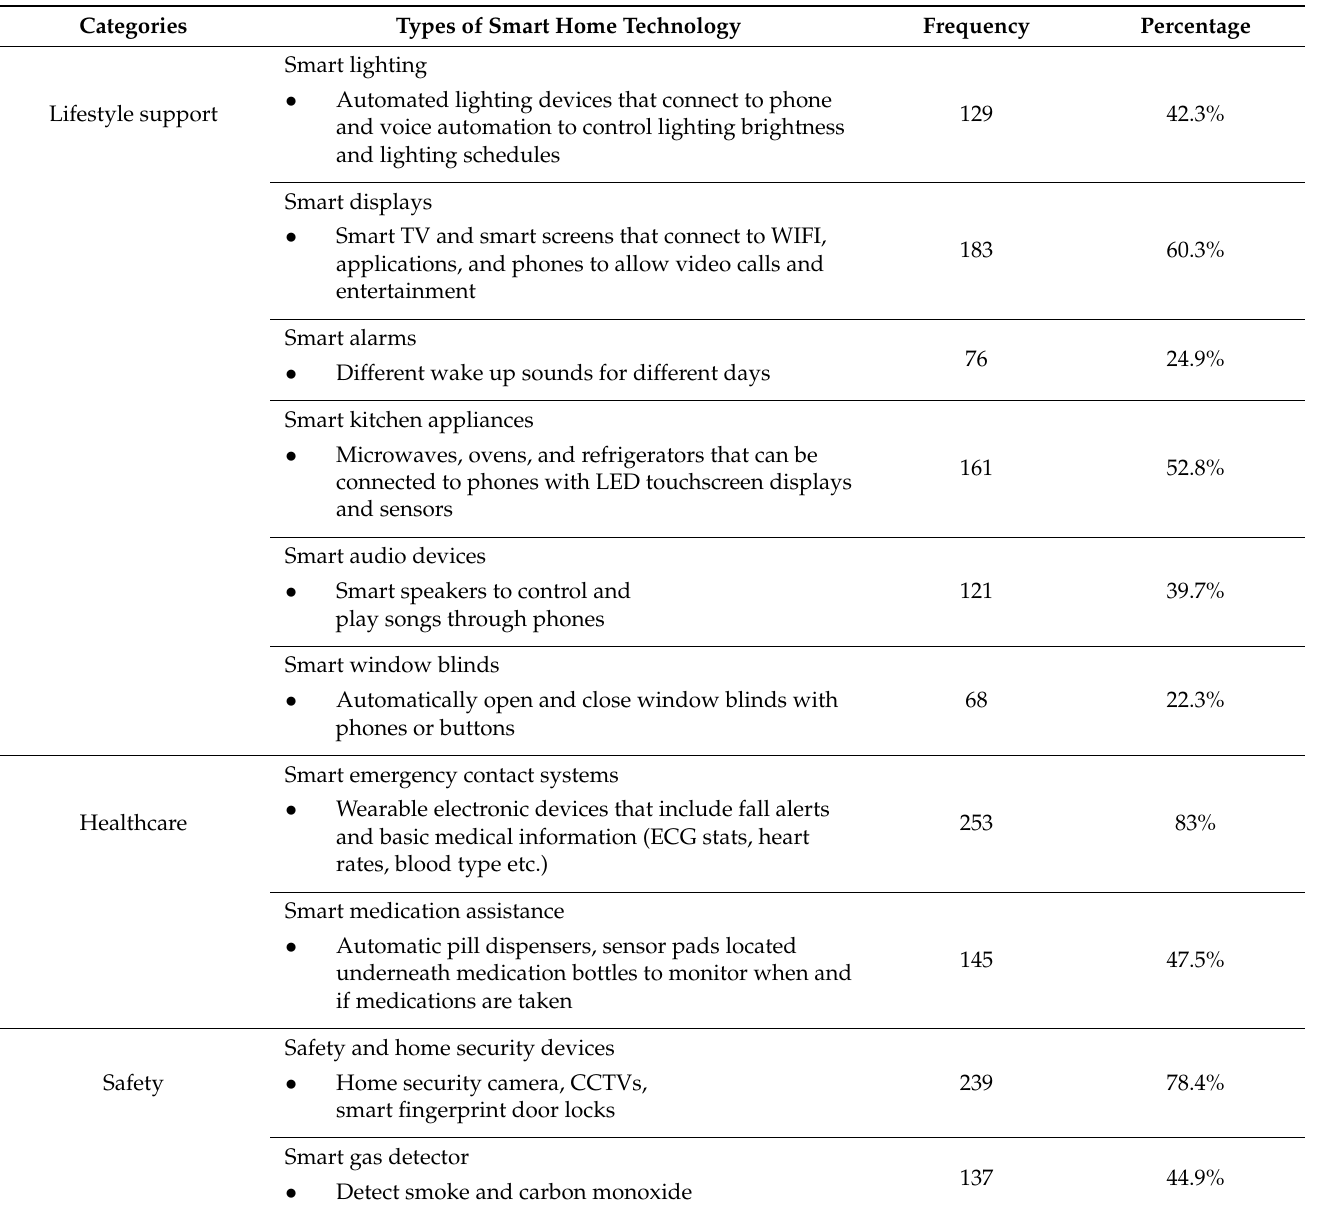
Table 2. Types of smart home technology preferred by the elderly ( N =